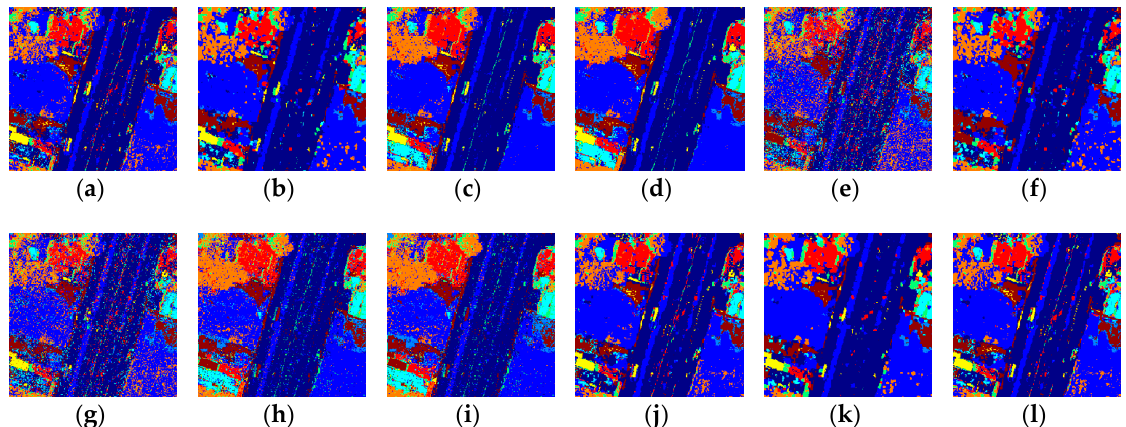
Figure 8. Classification results on the Geoeye image obtained by using the ( a ) k-NN, ( b ) k-NN-WH-MV, ( c ) k-NN-SRM, ( e ) k-NN-SRM-IC, ( e ) OPF, ( f ) OPF-WH-MV, ( g ) OPF-MRF, ( h ) OPF-SRM, ( i ) OPF-SRM-IC, ( j ) SVM, ( k ) SVM-WH-MV, ( l ) SVM-MRF.